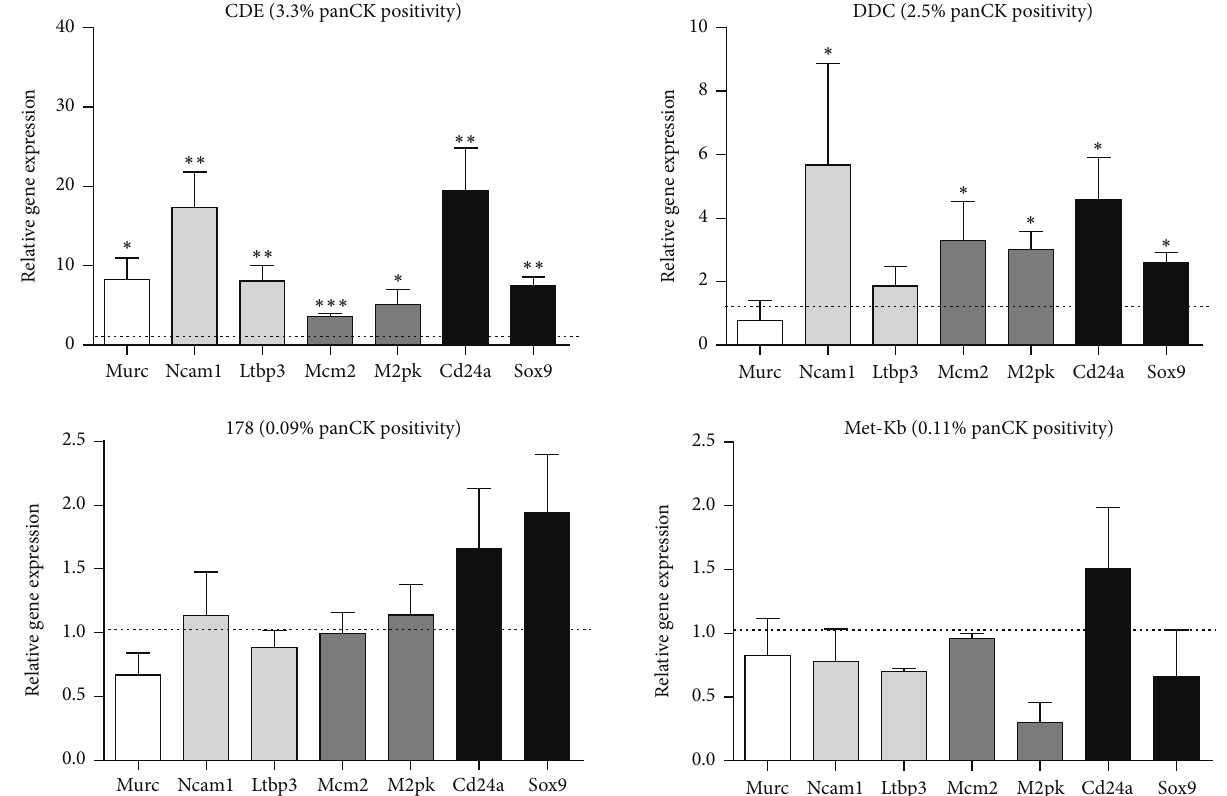
Figure 6: A liver progenitor cell (LPC) transcriptomic signature can identify liver injury models with LPC induction. qPCR-generated mRNA expression levels of known ( Cd24a and Sox9 ) and identified (group 𝛼 , Murc ; 𝛽 , Ncam1 and Ltbp3 ; and 𝛾 , Mcm2 and M2pk ) LPC markers in four different liver injury models. Data are normalized to gene expression in the appropriate control livers (indicated by the dotted line) and are relative to the Taf4a housekeeping gene. Data represents mean + SEM of 3 separate qPCR assays with significance determined by Student’s 𝑡 -test ( ∗ 𝑝 < 0.05 , ∗∗ 𝑝 < 0.01 , and ∗∗∗ 𝑝 < 0.001